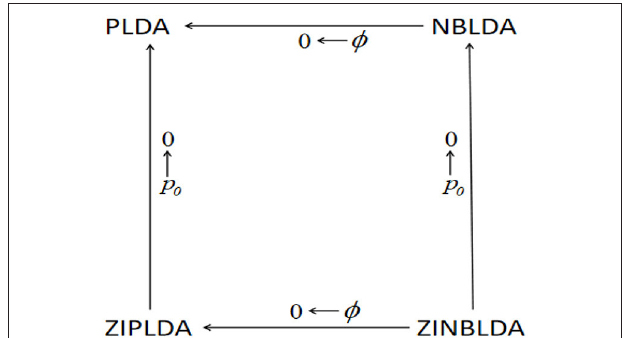
FIGURE 1 | The transformation relation between the four methods. Given a sufficient sample size, the four models can transform into one another according to the value of dispersion parameter φ and the average probability of excess zeros p 0